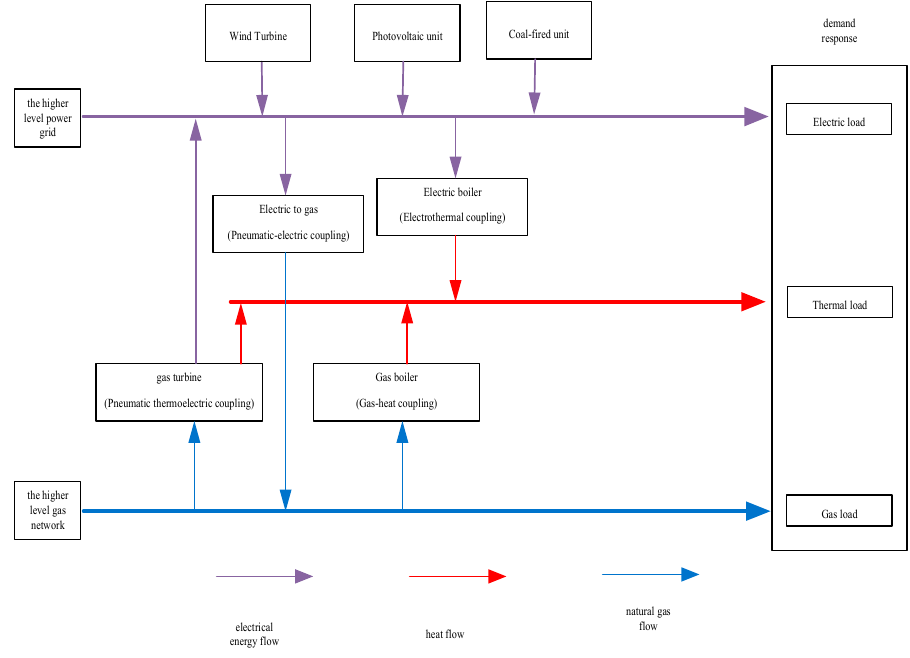
Figure 1. Integrated energy hub model.